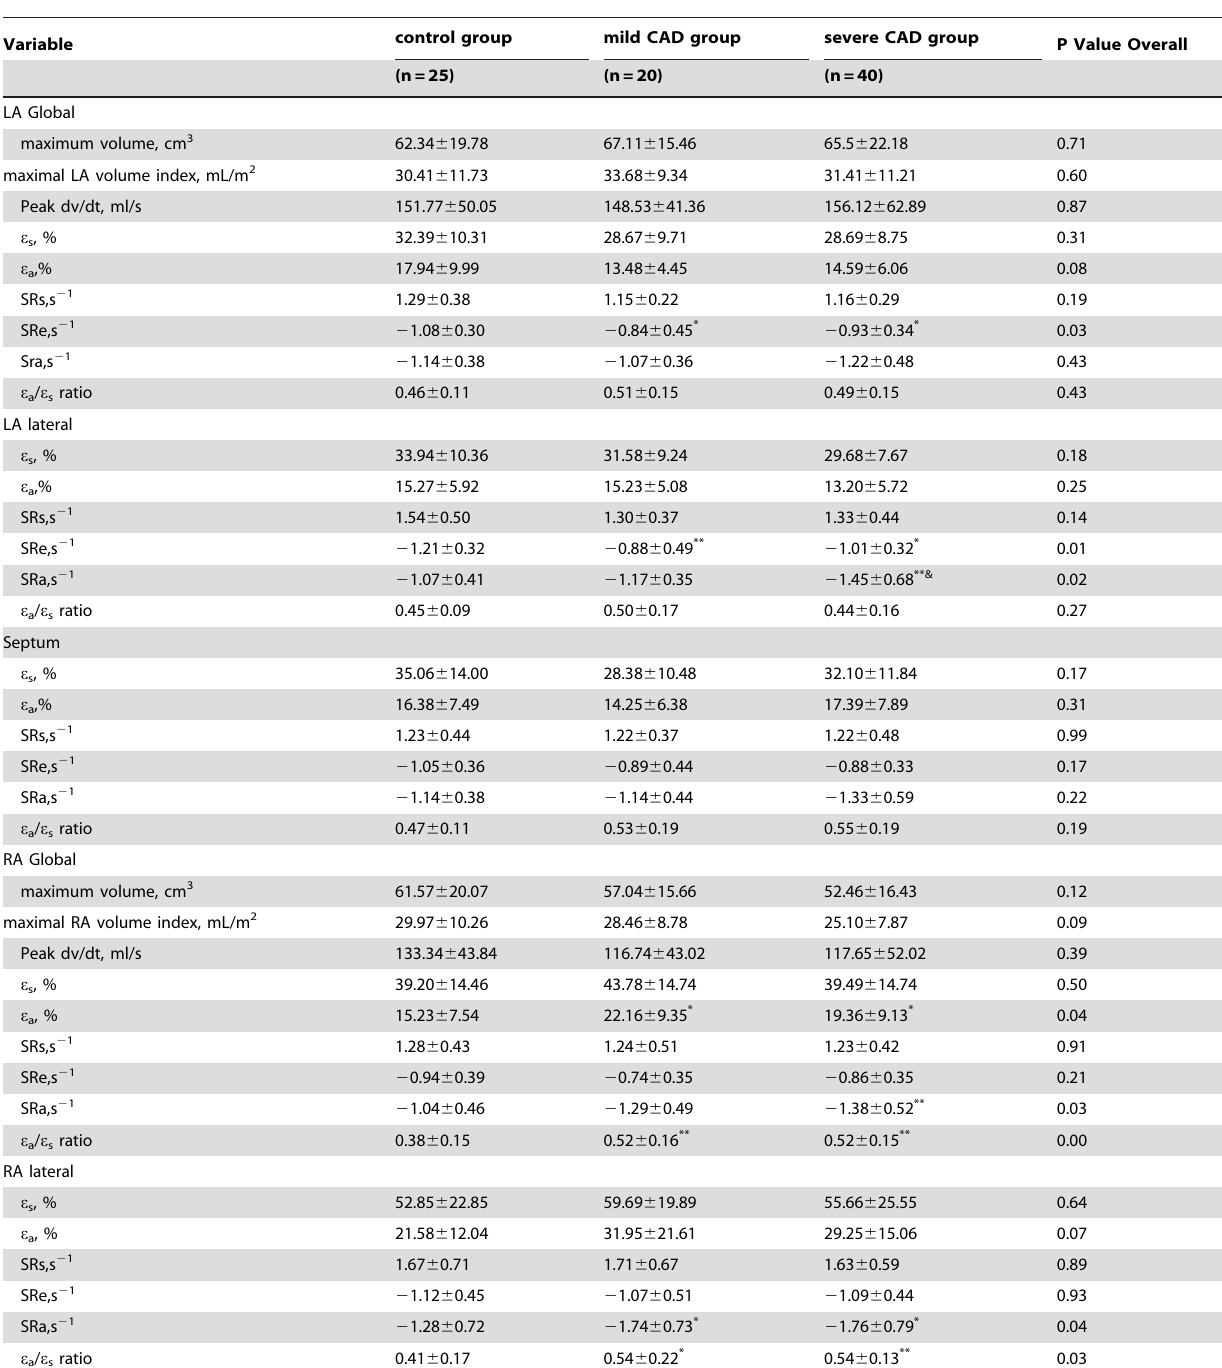
Table 3. Velocity vector imaging-based measurements of LA/RA according to the severity of coronary